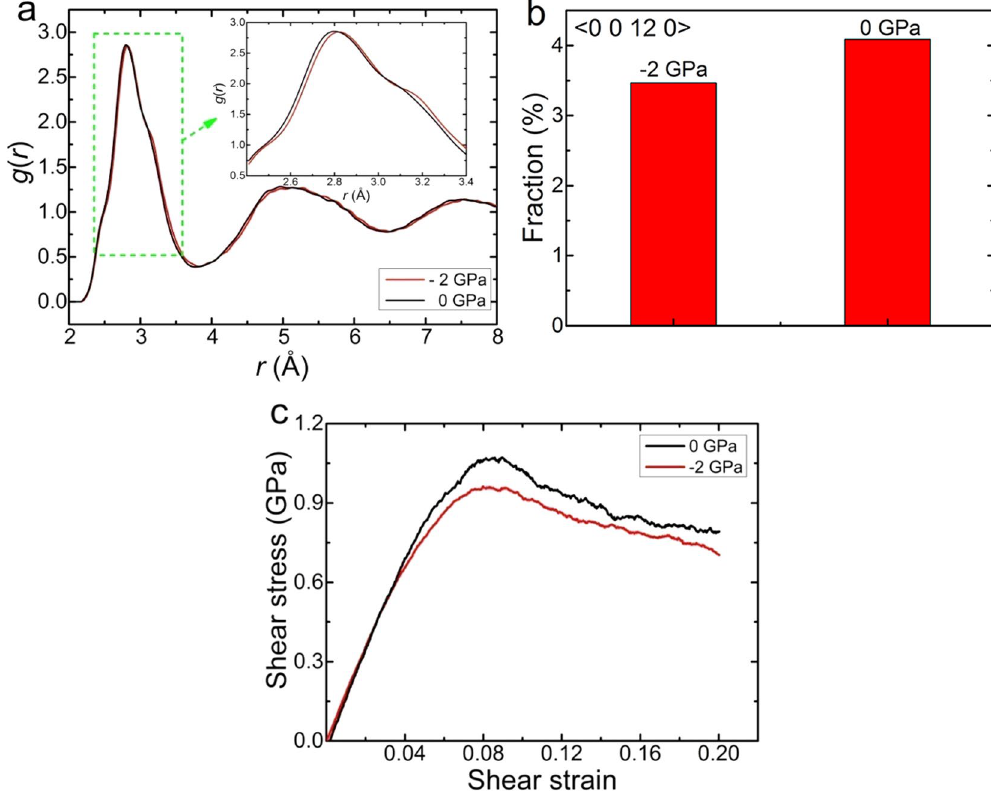
Figure 8. The MD simulation of Zr 50 Cu 44 Al 6 MG under a negative hydrostatic pressure P = − 2 GPa. ( a ) The g ( r ) curve on which the first peak position shifts to a larger radial distance for P = − 2GPa (red) compared with that for P = 0 GPa (black). ( b ) The fraction of icosahedra indexed as < 0 0 12 0 > becomes less for P = − 2 GPa than for P = 0 GPa. ( c ) The shear stength is reduced by the negative hydrostatic pressure at 300